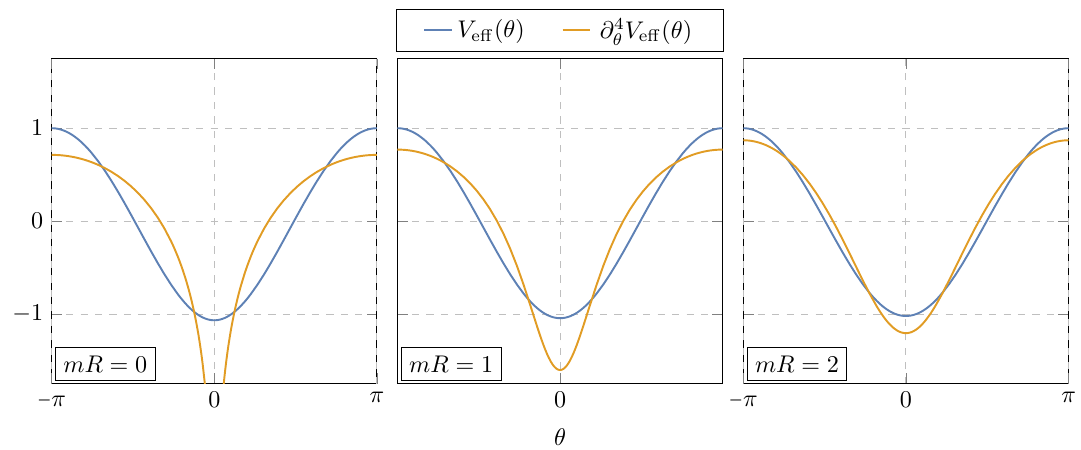
Figure 7. The effective potential (3.44) and its fourth derivative for various values mR , normalized so that V eff ( π ) = 1 . While the effective potential barely changes as we dial mR to zero, its fourth derivative at θ = 0 diverges, forcing the topological expansion to converge